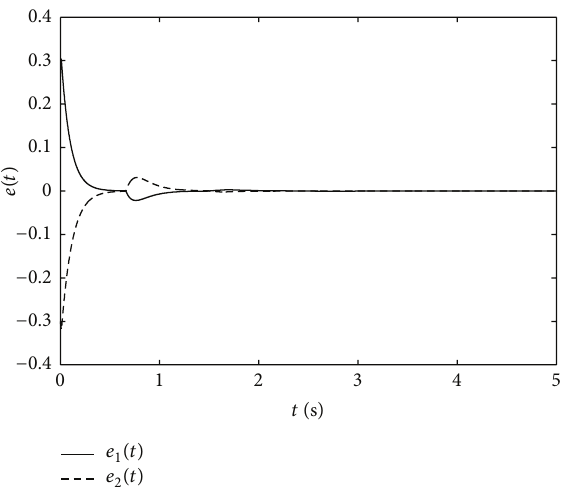
Figure 3: State response curves of the error